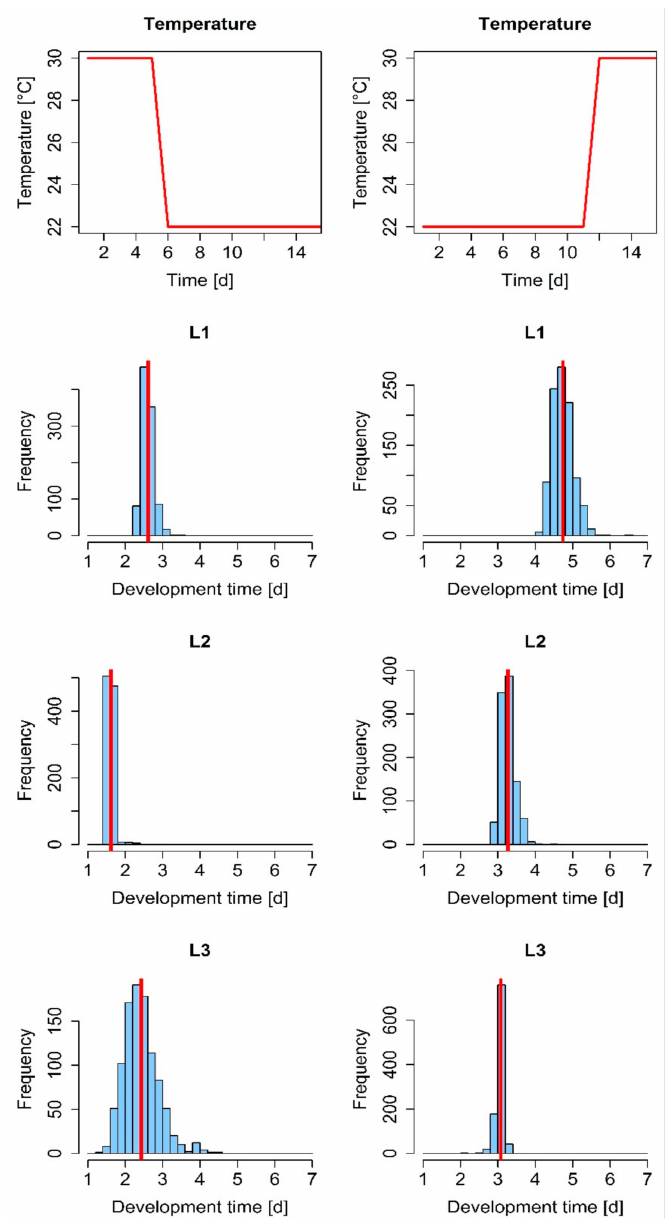
Figure 4. Simulated larval development for decelerating ( left ) and accelerating ( right ) temperature regimes. Blue columns represent the frequencies of the development times of larvae ( n = 1000), and the red vertical line in the histograms indicates the mean development time per